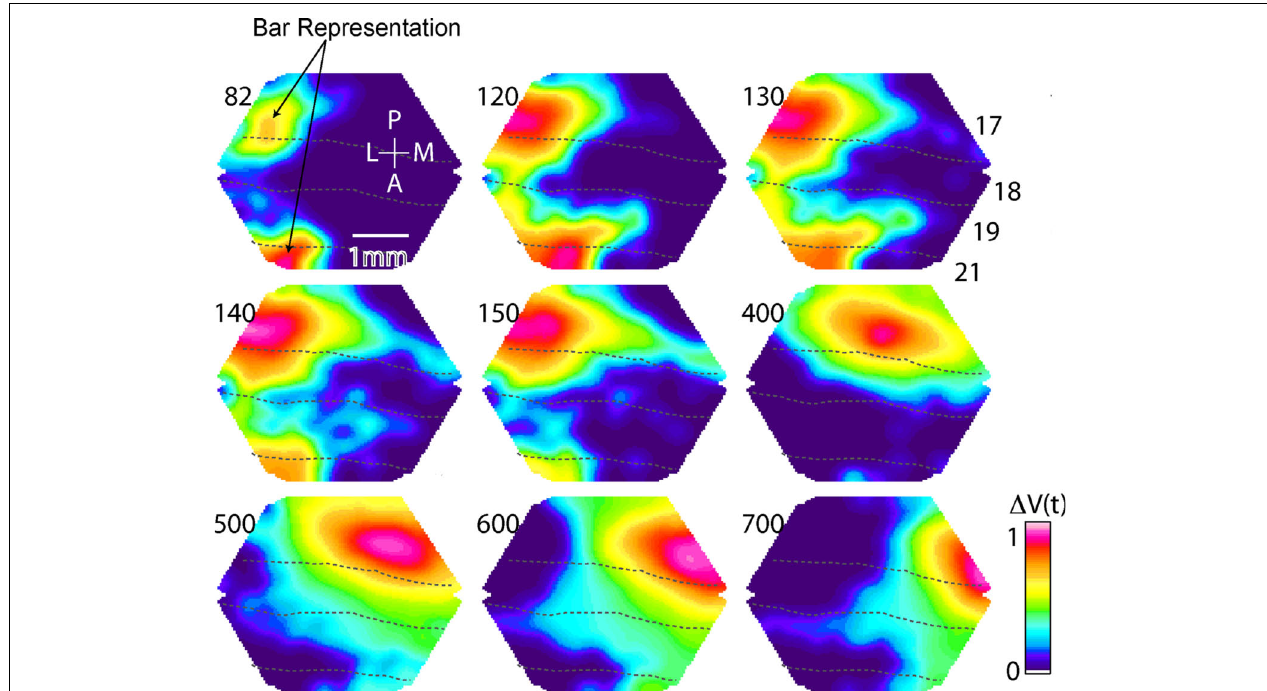
the 19/21 border and the representation at the 17/18 border and another emerges in front of the bar map in 19/21. At 140 ms this shifts direction towards the 17/18 border. Then a Δ V ( t ) increase emerges from the 17/18 bar map ahead in the direction of motion over cortex along the 17/18 border. This is the SRP. From 400 to 700 ms the object representation is shown as it moves regularly along the 17/18 border and arrives at the site of the tip of the SRP at ∼ 700